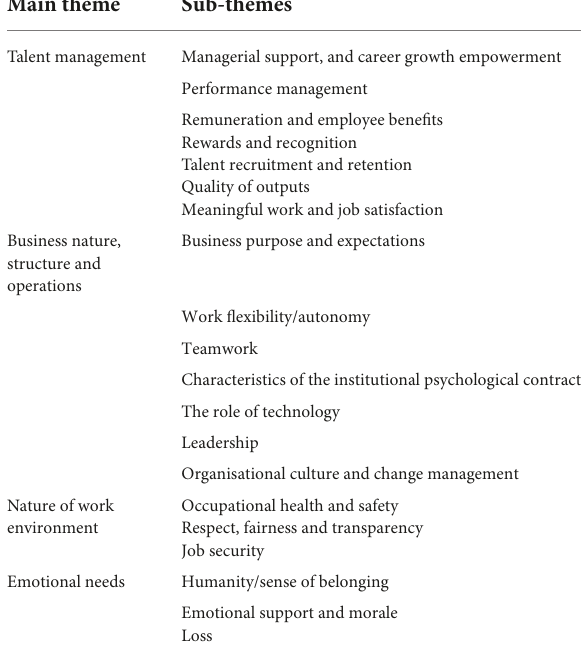
TABLE 1 Categories of main and